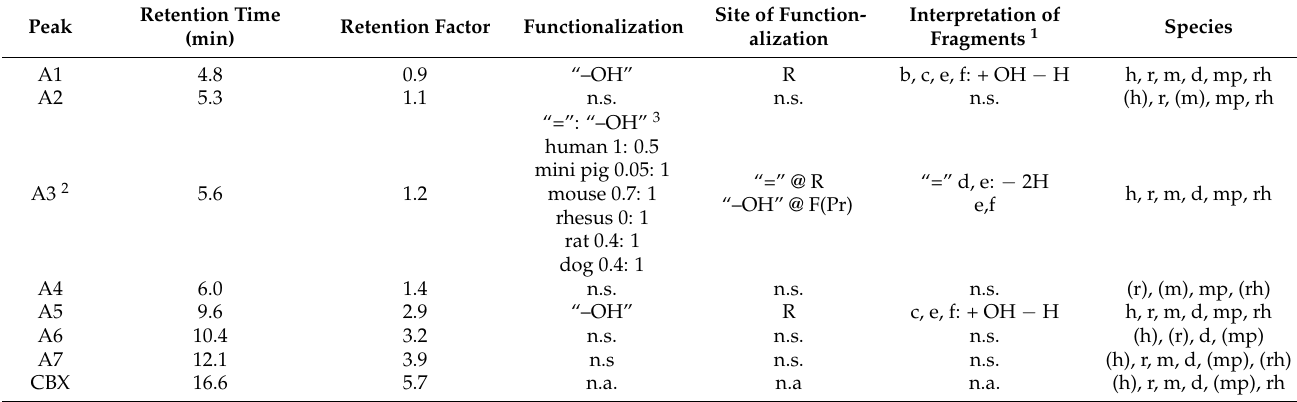
Figure 5. Base fragments ( a – f ) for interpretation of the in-source fragmentation pathways of the C8-substituted xanthine compounds. Table 2. Metabolites of CBX generated in liver microsomes from various species.